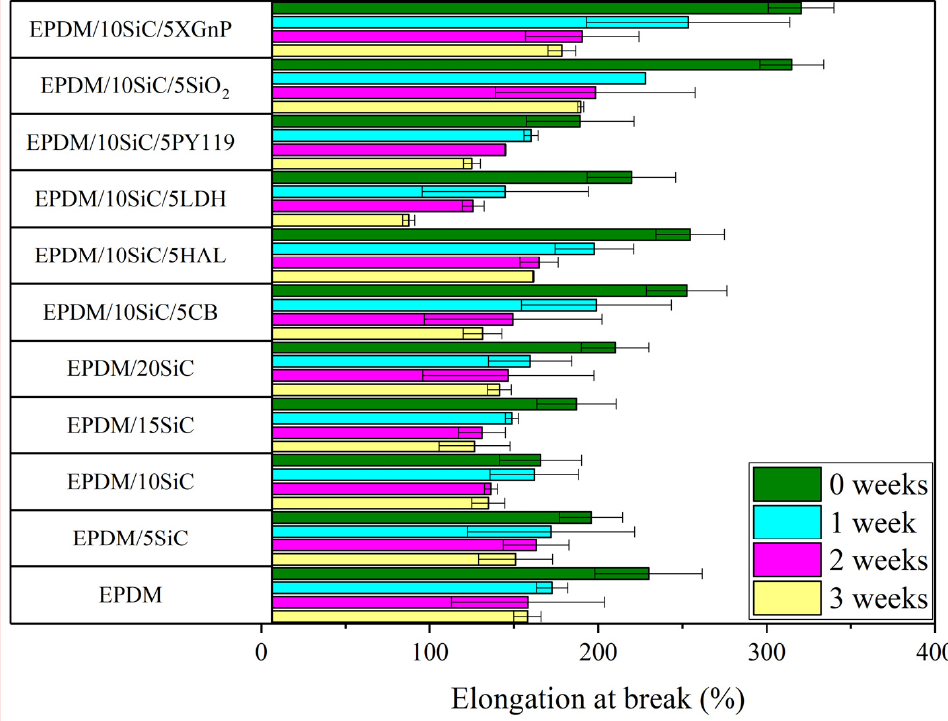
Figure 4. Elongation at break of composites before and after thermo-oxidative ageing.